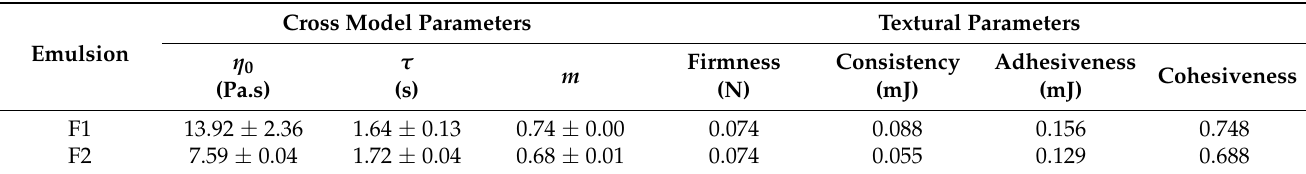
Table 6. Cross model parameters estimated for formulations samples: η 0 —apparent viscosity of the second Newtonian plateau (Pa · s); τ —relaxation time (s); m —dimensionless constant; Data are shown as the average ± standard deviation (SD) ( n = 3); and textural